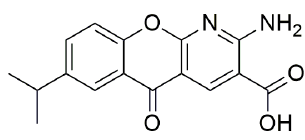
Figure 9. Structure of Clitocine.